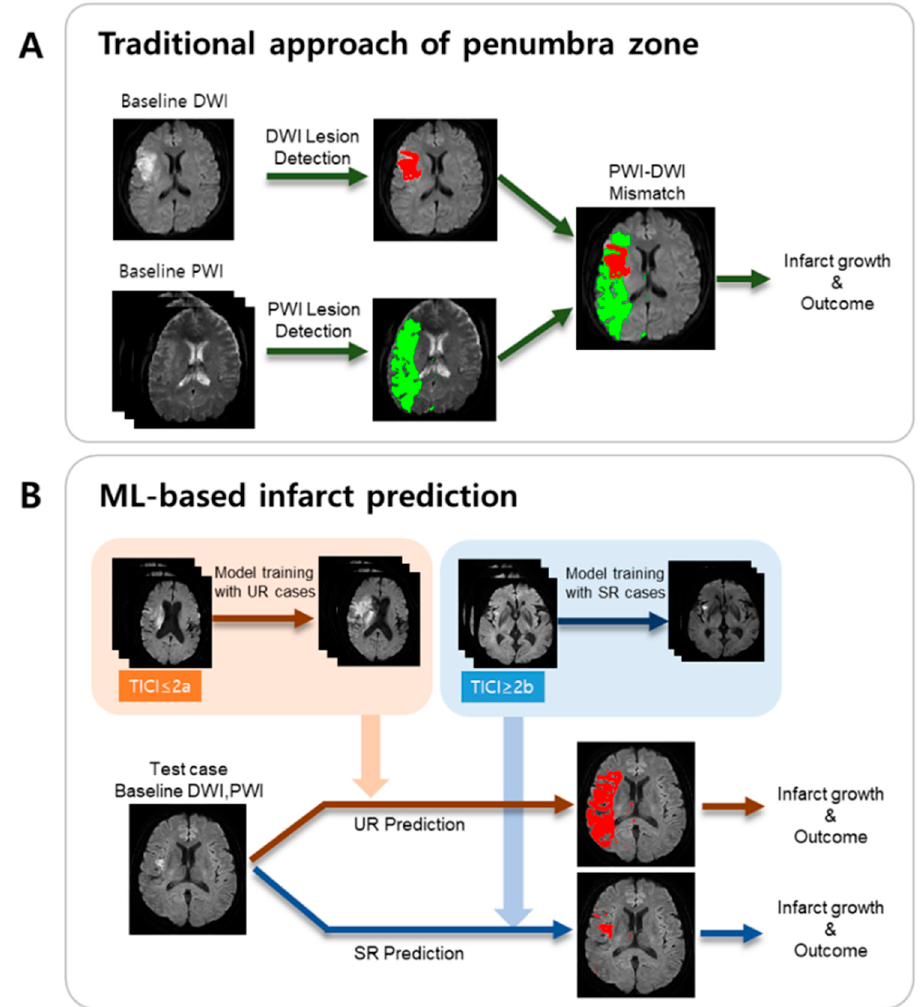
Figure 1. Schematics of two approaches for the estimation of final infarct volume and functional outcome. ( A ) Traditional approach of penumbra zone estimation. ( B ) Machine learning (ML)-based infarct prediction.